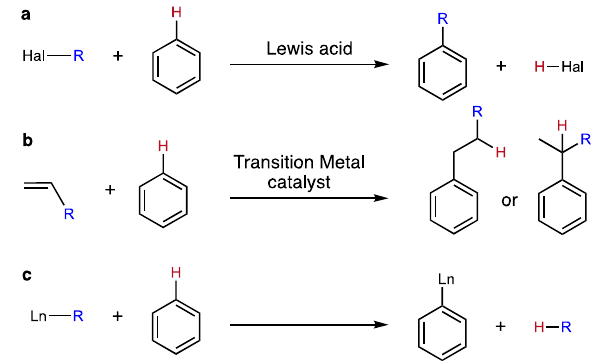
Fig. 1 Aromatic alkylation mechanisms and conventional lanthanide alkyl reactivity with a benzene C – H bond. a Friedel – Crafts alkylation. b Transition metal-catalysed hydroarylation of ole fi ns. c σ -bond metathesis of a lanthanide alkyl with a benzene C – H